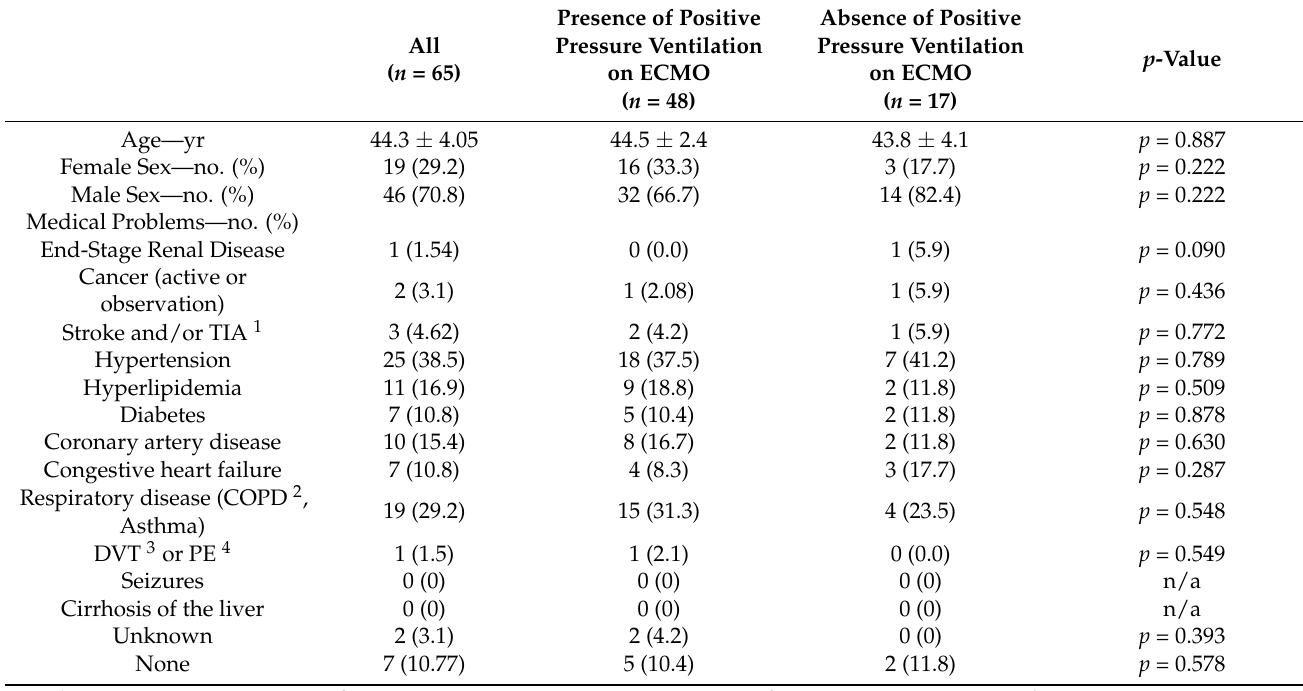
Table 1. Baseline patient characteristics of patients on extracorporeal membrane oxygenation (ECMO).